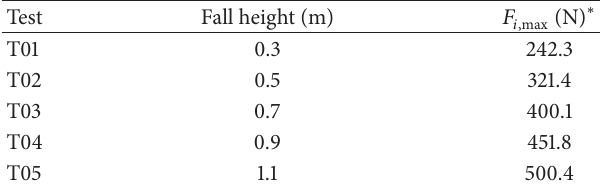
Table 1: Peak magnitude of the measured impact